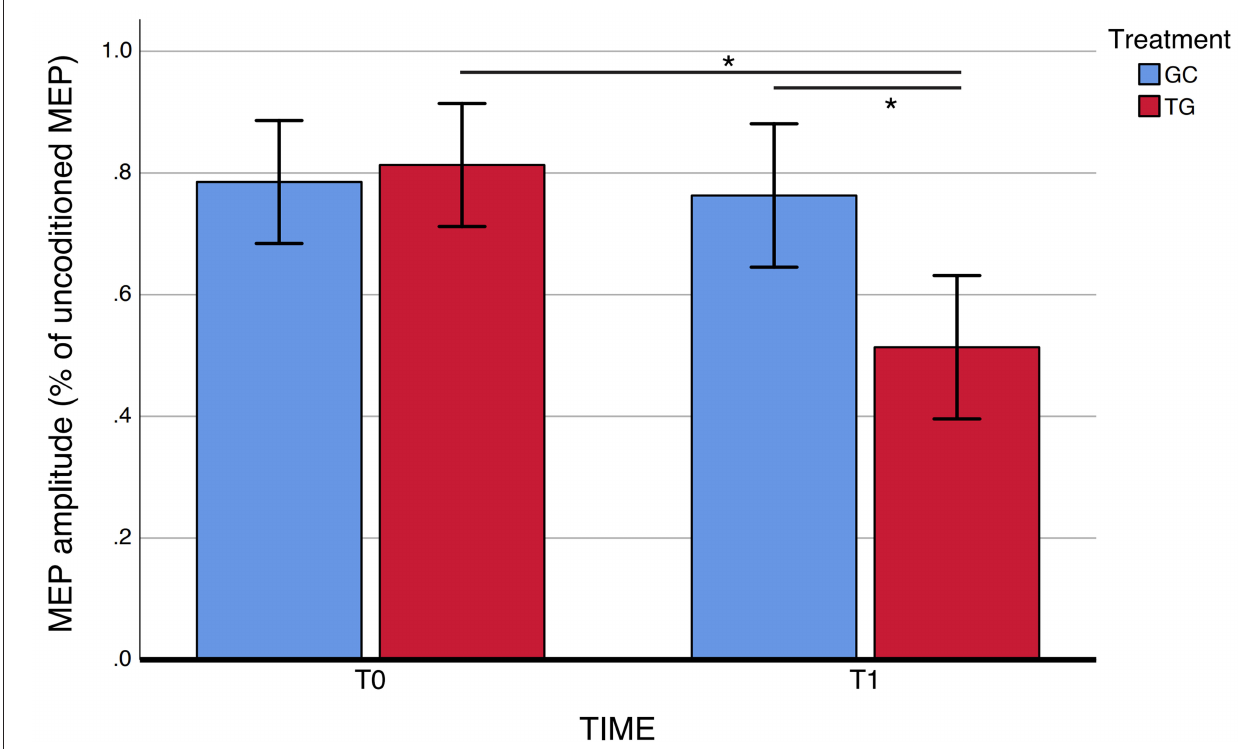
FIGURE 1 | SAI measures before and after exposure to CDP-choline treatment. SAI, short-latency afferent inhibition. Error bars represent standard errors. *Significant difference.